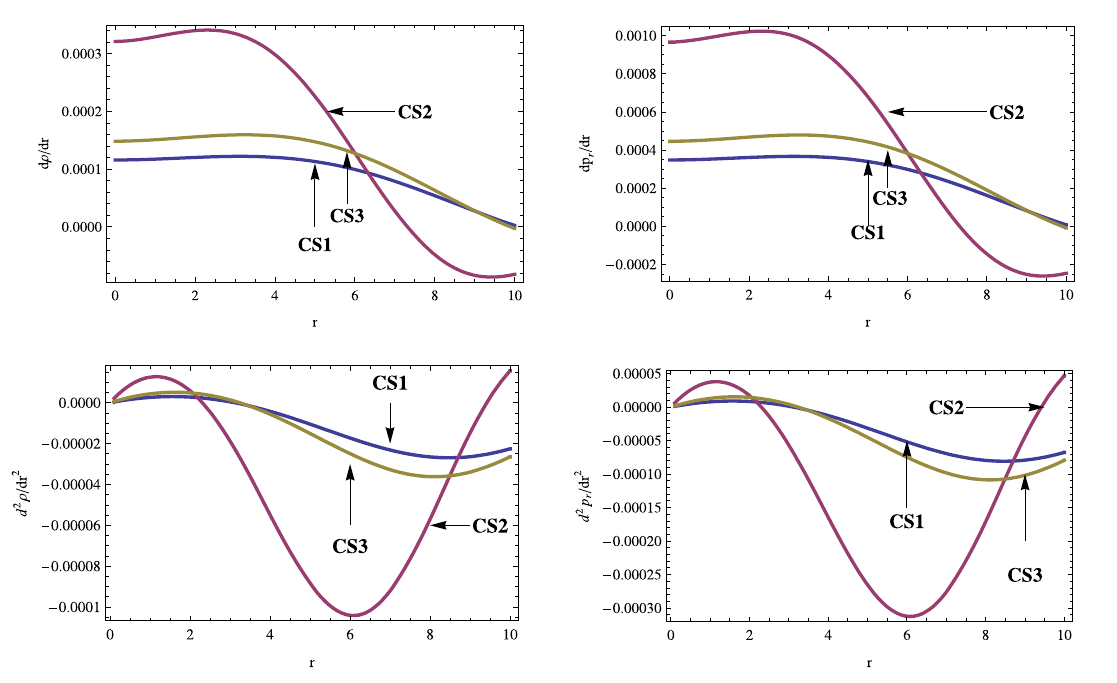
Fig. 7 Variations of derivatives of d ρ